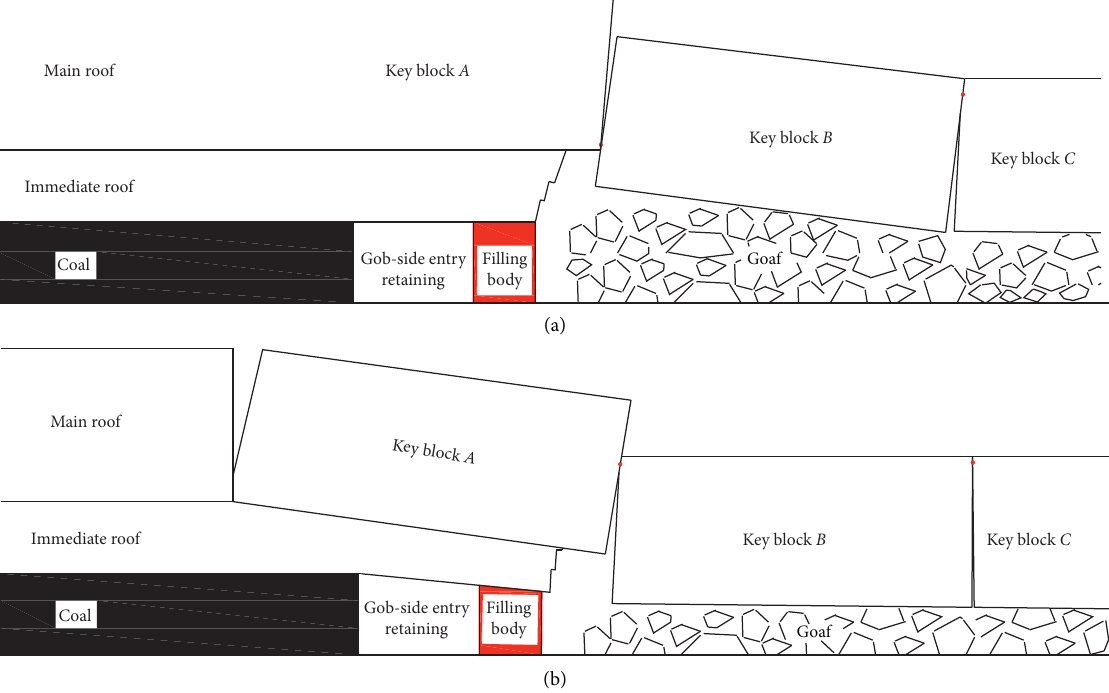
Figure 4: Structure form of short cantilever step rock beam. (a) Roof structure in the stage of gob-side entry retaining; (b) the roof structure in the reuse stage of gob-side entry retaining.